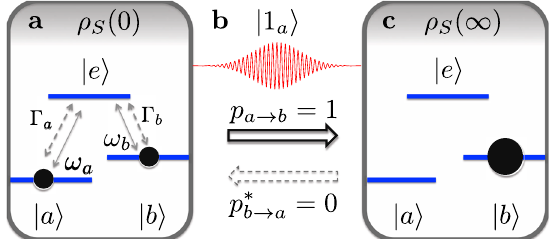
Fig. 1 Quantum dissipative adaptation in a driven self-organized quantum state. a Three-level system in lambda con fi guration is described by the density operator ρ S ( t ) at time t , starting at t = 0. The energy eigenstates are a j i , b j i , and e j i (blue horizontal bars). The transition frequencies are ω a , b (full gray arrows). The environment-induced spontaneous emission rates are Γ a , b (dashed gray arrows). The initial state is a mixture between a j i and b j i , ρ ð 0 Þ ¼ p ð 0 Þ a j i a h j þ p ð 0 Þ b j i b h j (smaller black dots). b A single-photon (cid:4) (cid:3) a S b (cid:4) pulse 1 a (the work source) drives the lambda system dynamics, inducing the time-dependent transition probability p a → b ( t ) from a j i to b j i (the full black horizontal arrow represents the forward dynamics from time t = 0 to t → ∞ ). The backward probability (with a time-reversed pulse), p (cid:2) ð t Þ ¼ 0, vanishes at zero temperature (the dashed gray horizontal b ! a arrow represents the prohibited time-reversed transition). c The driven lambda system undergoes an ideal irreversible self-organizing dynamics ( p a → b ( ∞ ) = 1 and p (cid:2) b ! a ð t Þ ¼ 0, in b ), so that the asymptotic state is pure, ρ ð1Þ ¼ b j i b h j (larger black dot), conditioned to maximizing the work S absorbed and the heat dissipated in the a j i to b j i